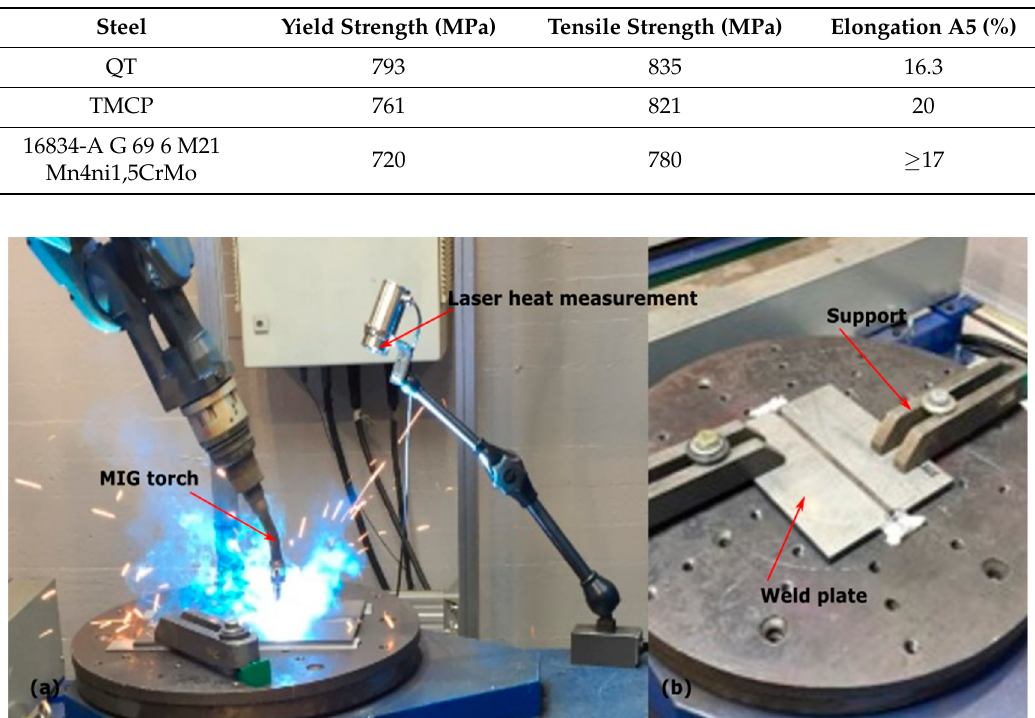
Figure 2. Gas metal arc welding process: ( a ) weld torch and laser heat control; ( b ) workpiece position. Table 3. Welding